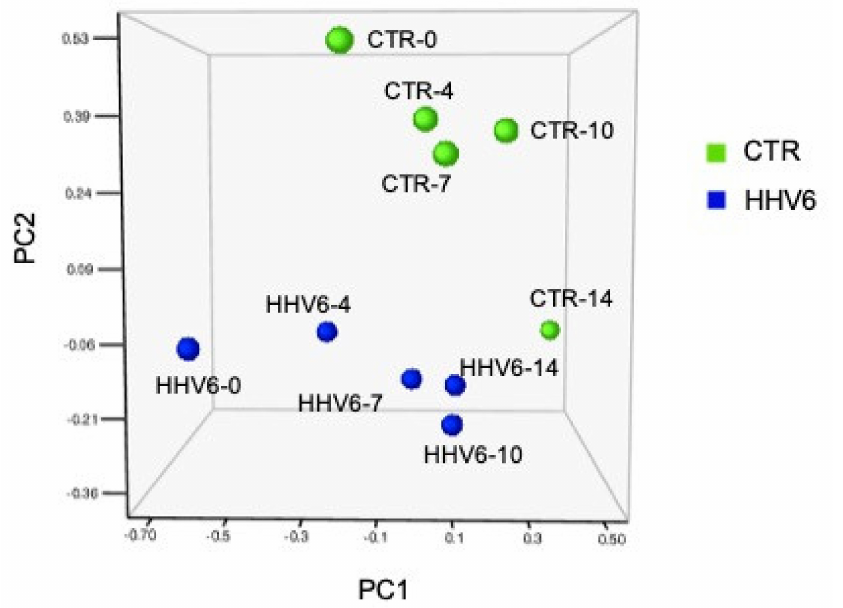
Figure 4. Principal Component Analysis (PCA) of miRNA expression in human herpesvirus 6A (HHV-6A) infected and control uninfected cells (CTR). Tridimensional graph representing miRNA clusters at the different times post infection. HHV-6A-infected and CTR cells are displayed. Days post-infection (d.p.i.) are also indicated after the sample